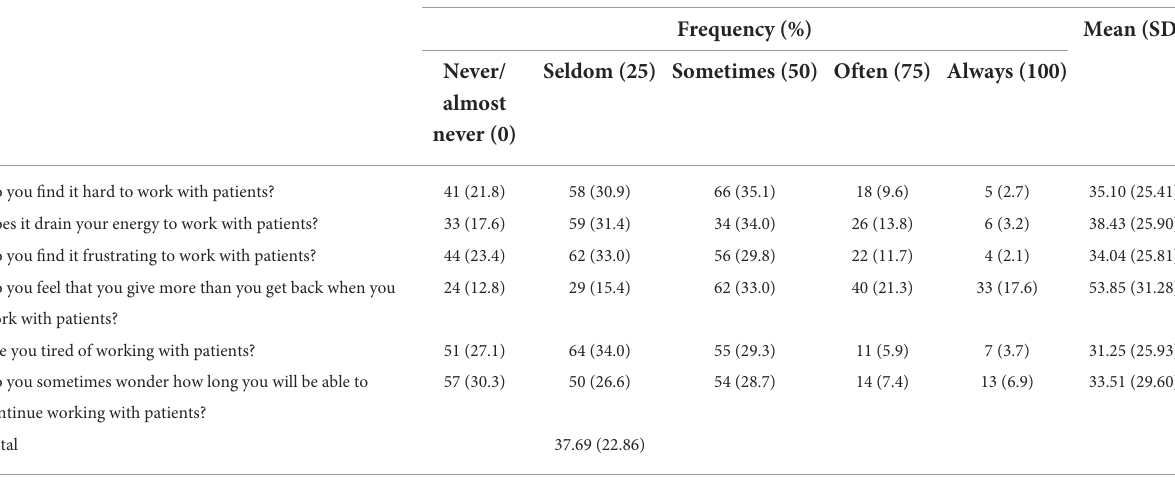
TABLE 2C Frequency distribution, mean and SD of the patient-related burnout